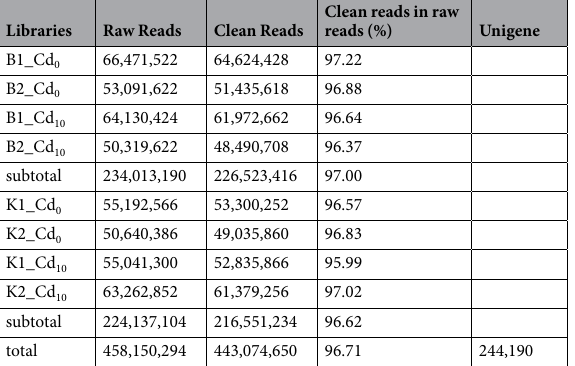
Table 1. Summary of Illumina transcriptome sequencing from pak choi